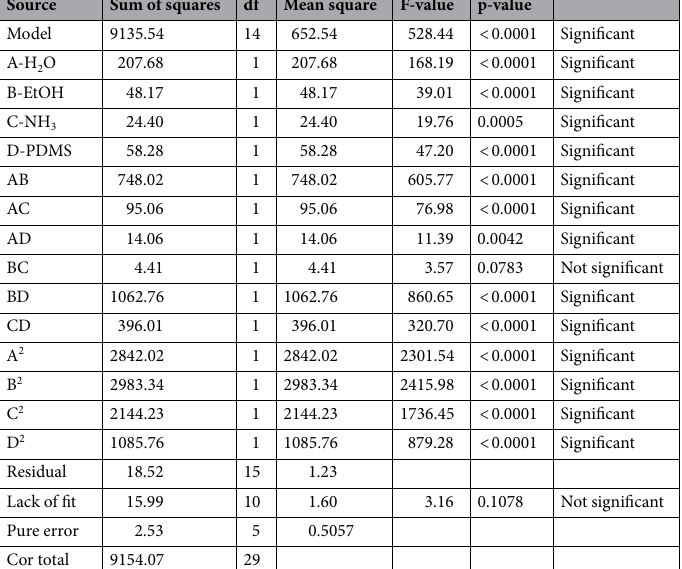
Table 4. Analysis of